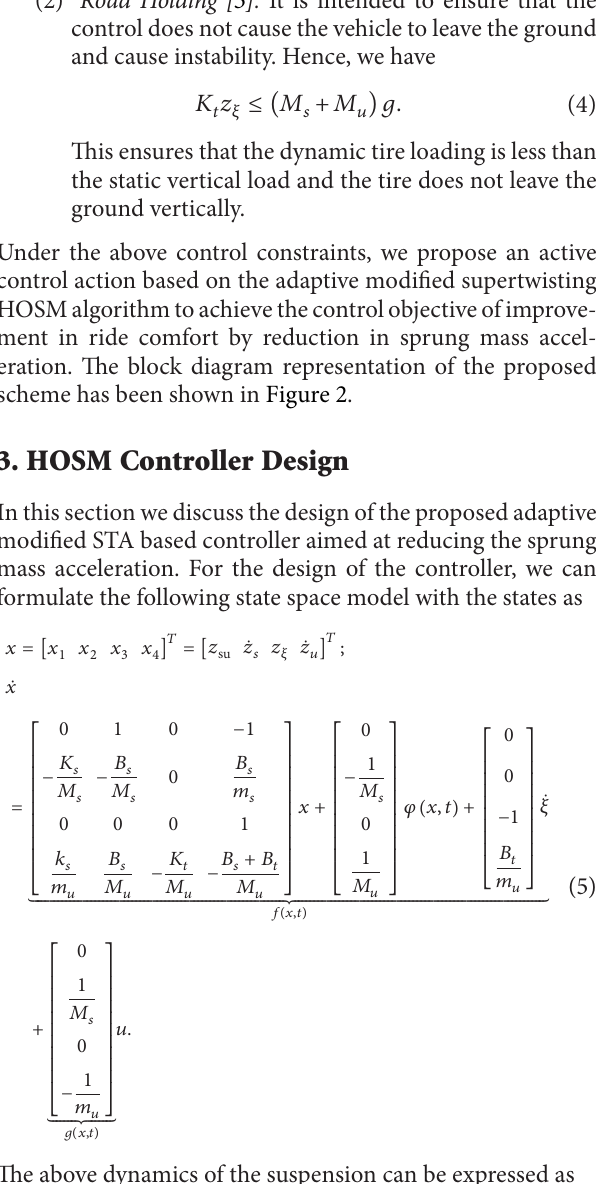
(2) Road Holding [5]. It is intended to ensure that the control does not cause the vehicle to leave the ground and cause instability. Hence, we